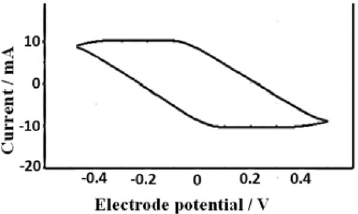
Figure 4. Cyclic voltammogram of the prepared substituted polymer 2. Scan rate of 100 mV s −1 .